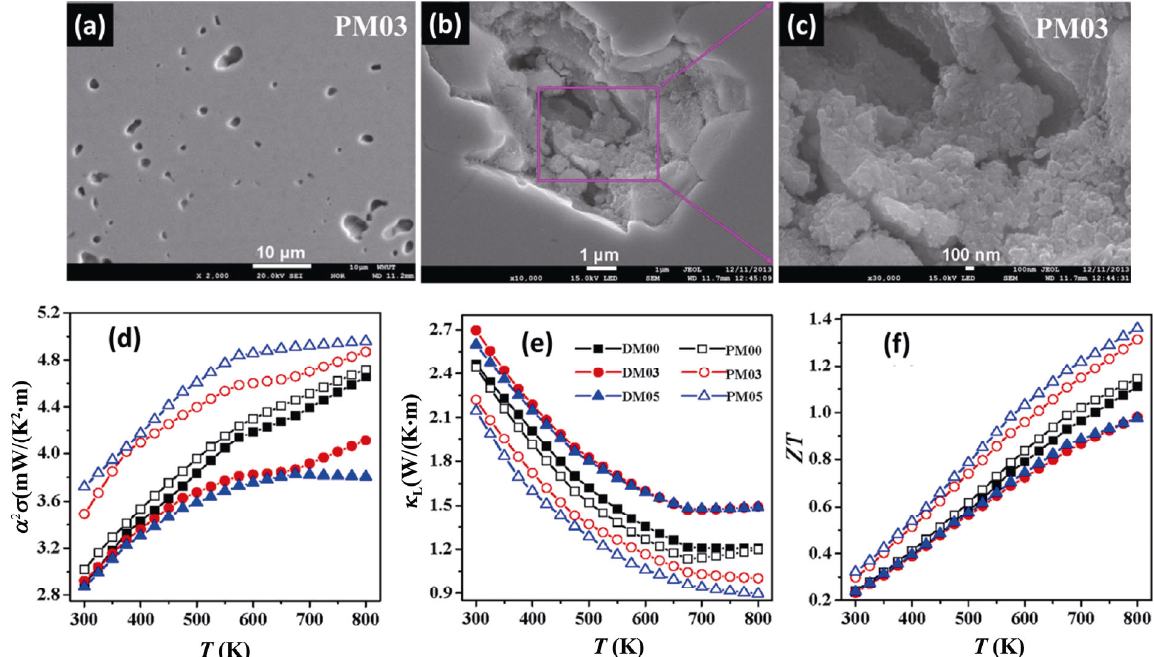
Fig. 8 Microstructure and thermoelectric properties of the dense (DM) and microporous x Zn/Ba 0.3 In 0.3 Co 4 Sb 12 materials (PM), Zn particles were added in the as-prepared Ba 0.3 In 0.3 Co 4 Sb 12 powders before SPS sintering according to molar ratio of Zn:Ba 0.3 In 0.3 Co 4 Sb 12 = x :1 ( x = 0, 0.3, 0.5). The dense materials were named as DM00, DM03, and DM05, respectively. All the dense materials were annealed at 753 K for 72 h to obtain Ba 0.3 In 0.3 Co 4 Sb 12 porous materials (PM). The resulting porous materials were termed as PM00, PM03, and PM05, respectively. (a) SEI photographs of PM03; (b, c) FESEM photographs of the porous structures of PM03. Temperature dependence of (d) power factor, (e) lattice thermal conductivity, and (f) ZT values for the DM and PM materials. Reproduced with permission from Ref. [155], © AIP Publishing LLC.